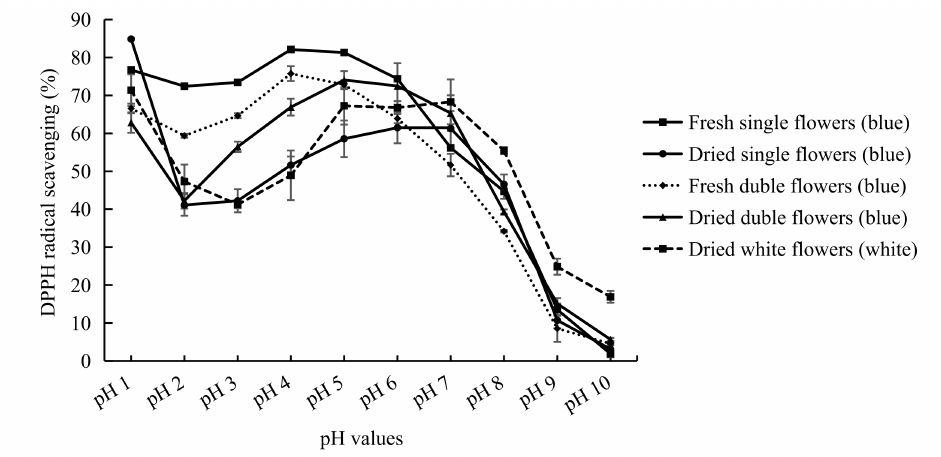
Figure 5. DPPH radical scavenging percentage for extracts of C. ternatea flowers at different